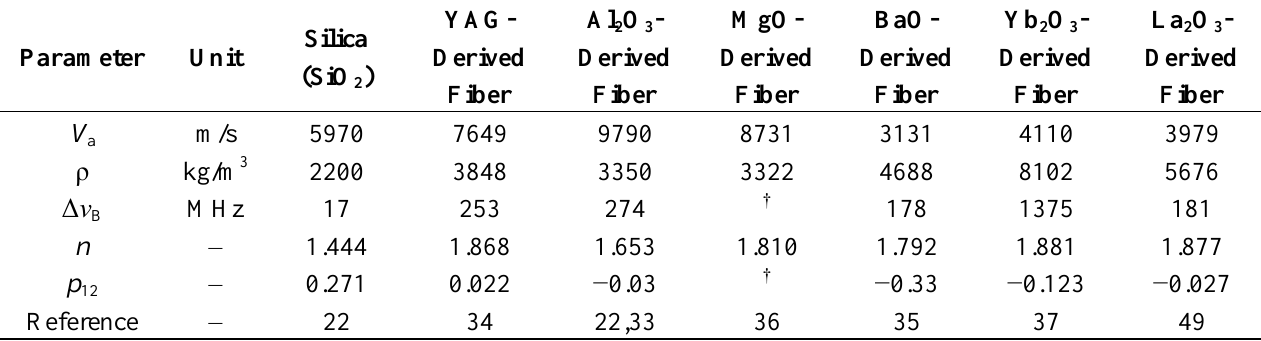
Table 1. Brillouin-Gain-Related Material Parameters from Selected Crystal-Derived All-Glass Optical